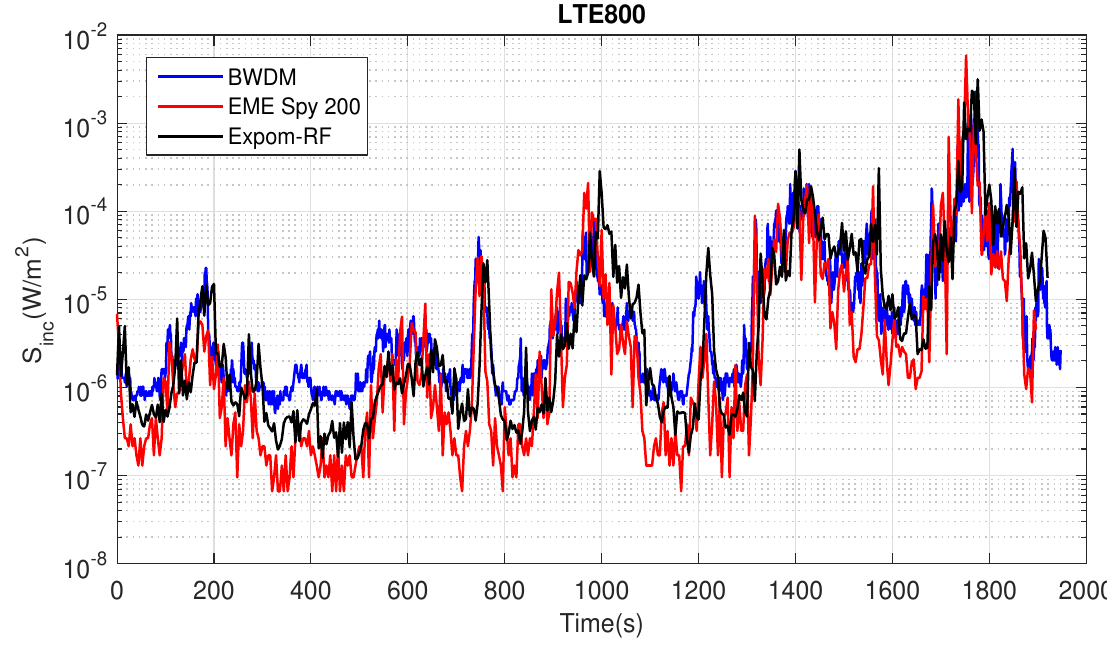
Figure 9. An example of the incident power densities measured during the walk for